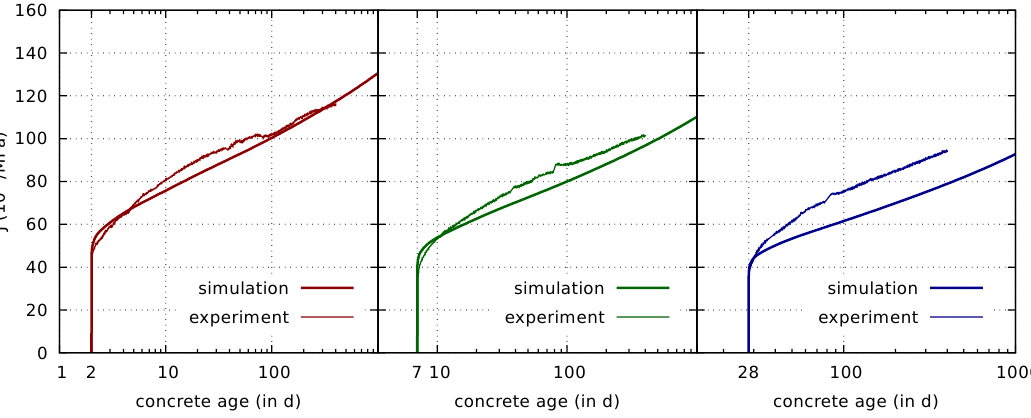
Figure 8. Comparison of measured [7] and computed drying creep compliances for loading and the beginning of drying at concrete ages of 2 days ( left ), 7 days ( center ), and 28 days ( right ),